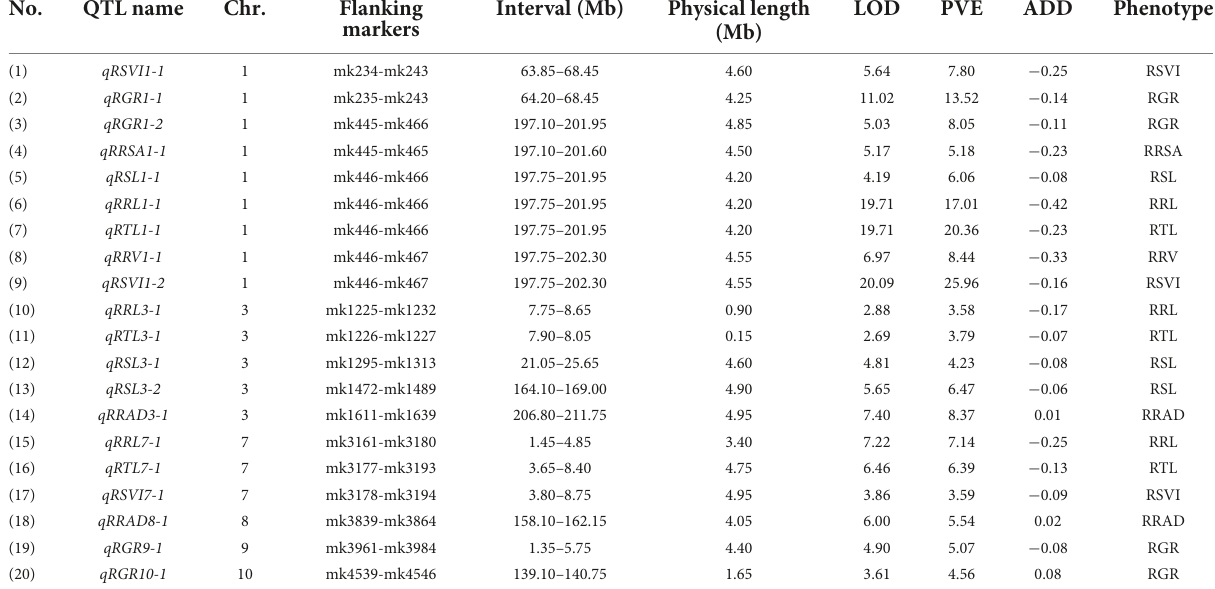
TABLE 1 QTLs identified for eight maize cold-related